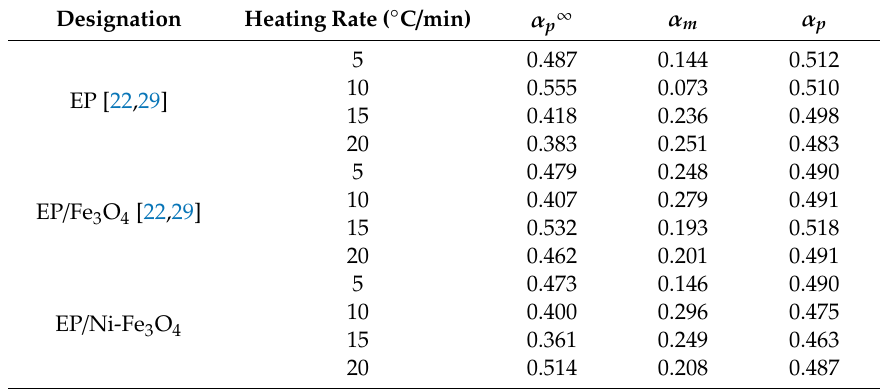
Table 2. The values of α p , α m and α p ∞ obtained from the Malek model at various heating rates.